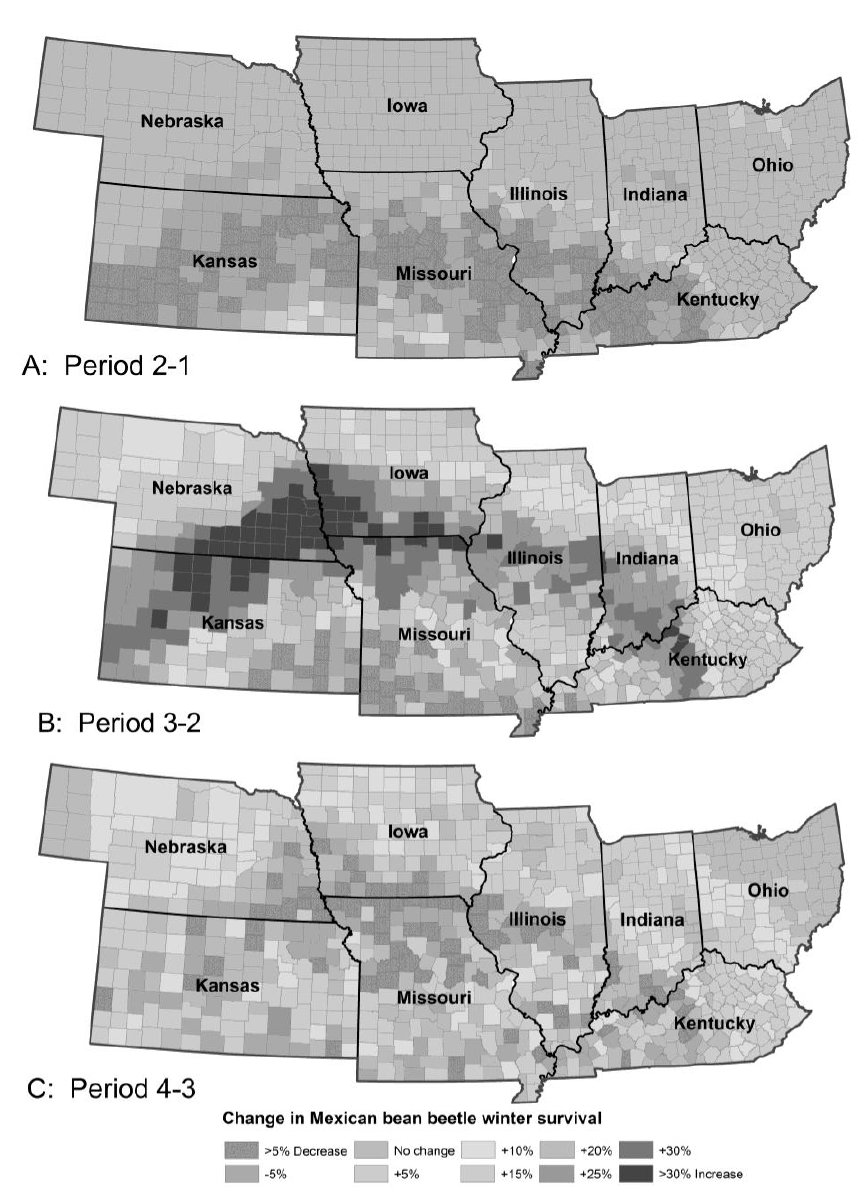
Figure 5. The model predicted almost no climate-related change in percent of Mexican bean beetle surviving the winter from Period 1 to 2 ( A ) but a large increase in winter survival from Period 2–3 ( B ) and a shift in the isoclines as well as a small increase in survival from Period 3–4 ( C ). The pattern of survival of bean leaf beetle and European corn borer were similar although the values differed with European corn borer having the overall biggest increase in overwintering survival and bean leaf beetle the smallest.